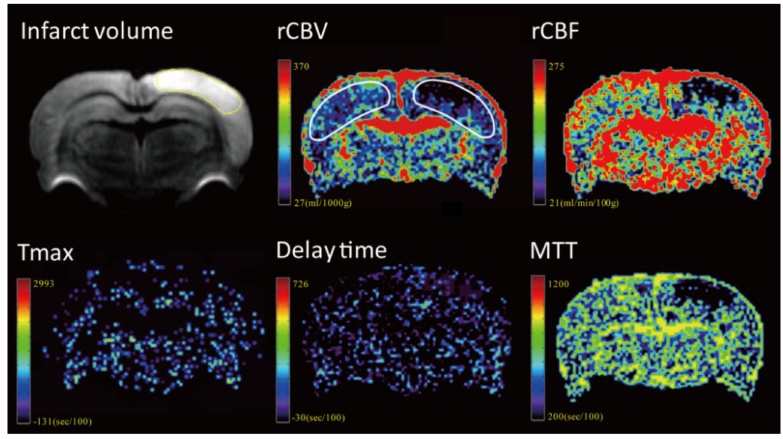
Figure 3. Representative images from one rat of the rehydration